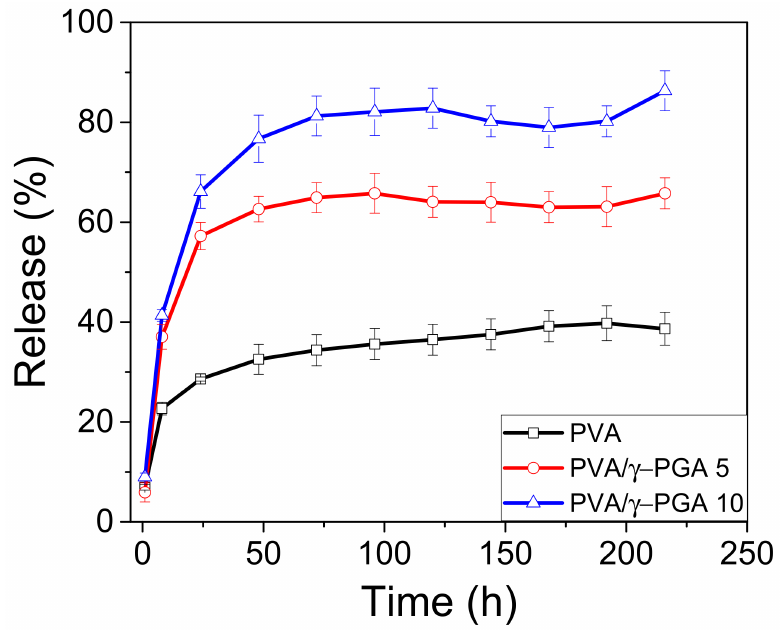
Figure 4. The release profiles of chlorogenic Acid from PVA, PVA/ γ -PGA 5, and PVA/ γ -PGA